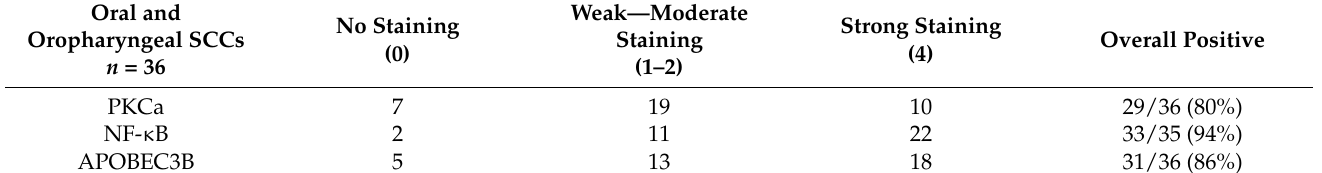
Figure 1. Immunohistochemical expression of PKC α , NF- κΒ , and APOBEC3B: ( a ) cytoplasmic ex- pression of PKC α ; ( b ) cytoplasmic expression of NF- κΒ ; ( c ) nuclear and cytoplasmic expression of APOBEC3B in an oral squamous cell carcinoma; ( d ) cytoplasmic expression of PKC α ; ( e ) cytoplas- mic expression of NF- κΒ ; and ( f ) nuclear and cytoplasmic expression of APOBEC3B in an oropha-